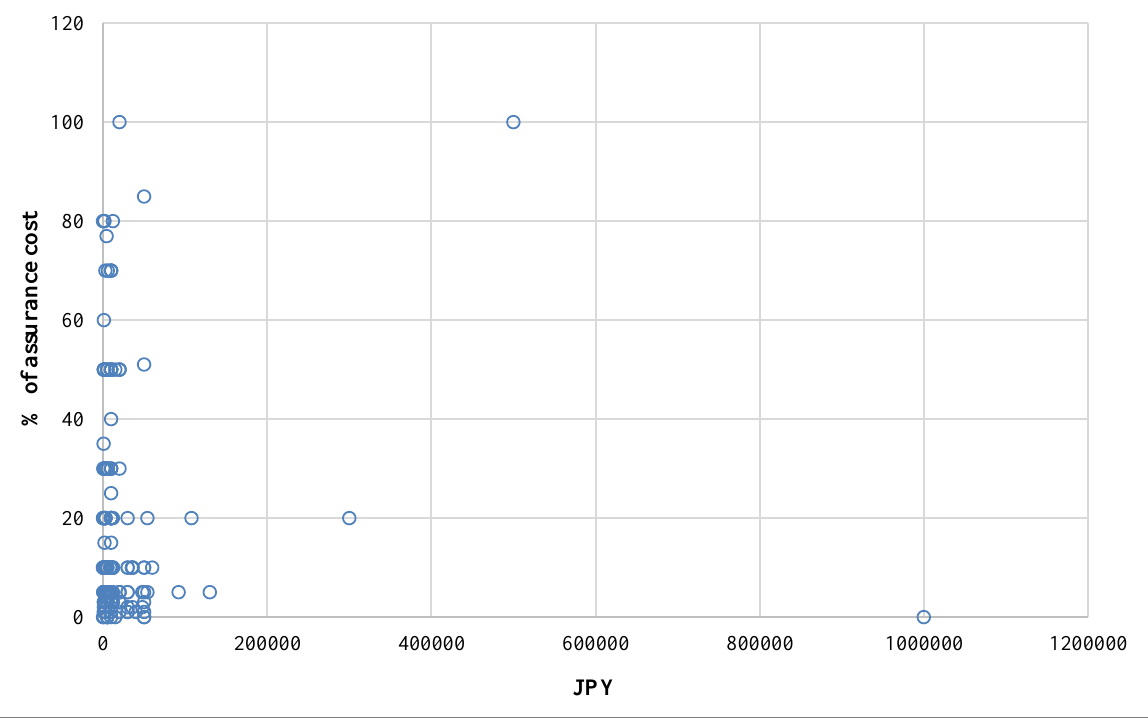
Figure 2. Scatter diagram to find abnormal dots.